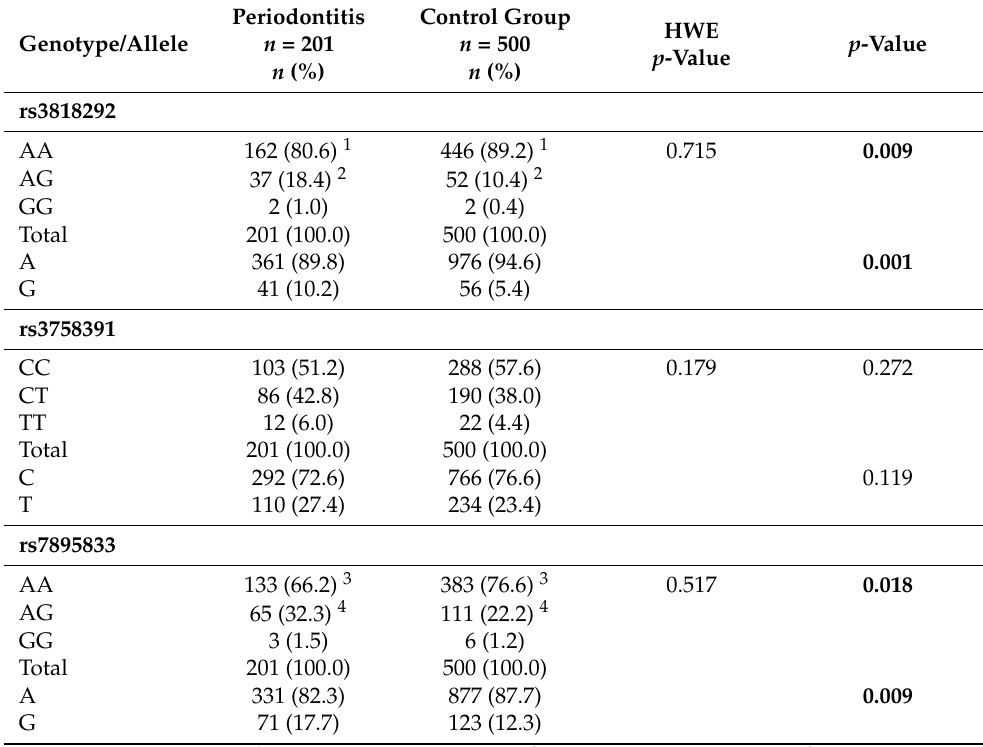
Table 2. Genotype and allele distribution of SIRT1 rs3818292, rs3758391, and rs7895833 in periodonti- tis and control